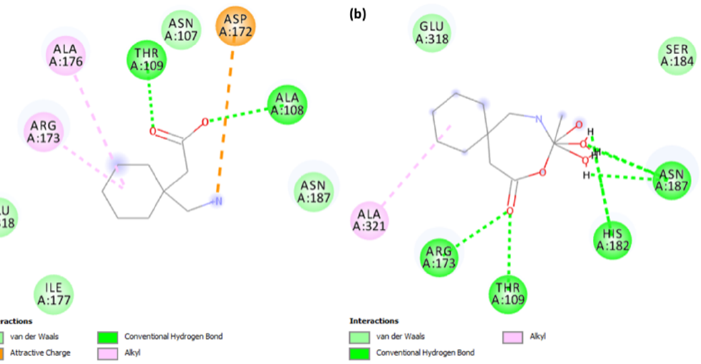
Figure 8. The 2D representation of interactions for serotonin (PDB ID: 6BQH) docked with ( a ) the Gpn drug and ( b ) metal complex [Cu(II)–(Gpn)]. Table 4. The [Cu(II)–(Gpn)]–serotonin interaction results by Discovery Studio.